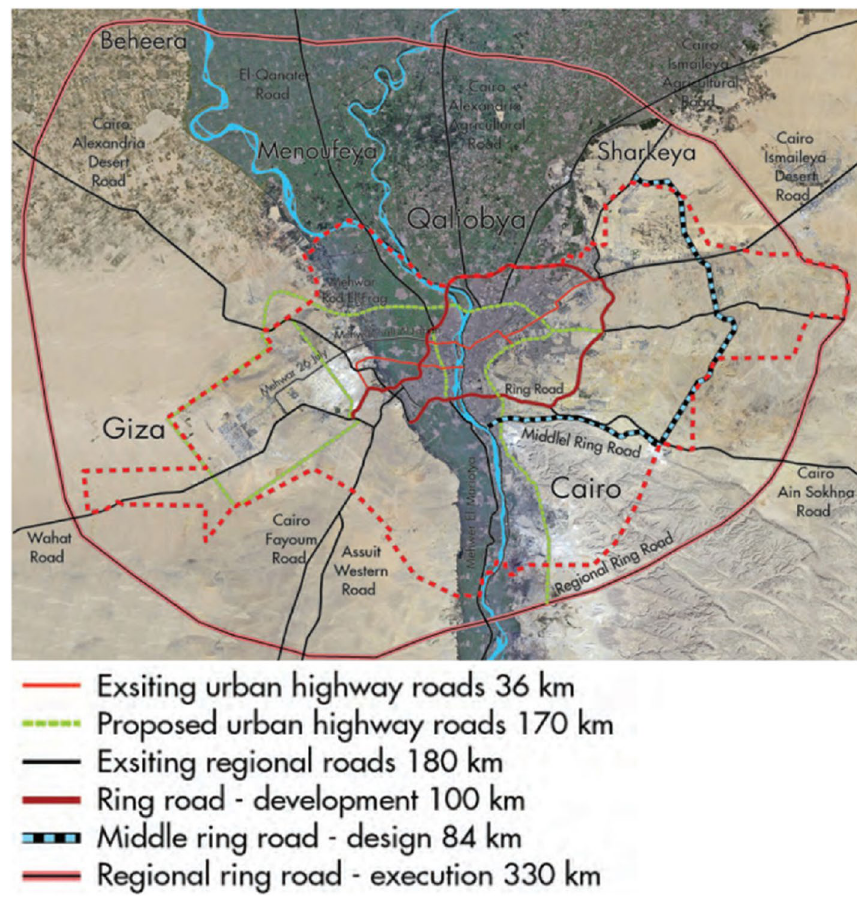
Fig. 2 Current and proposed 920-km-long road